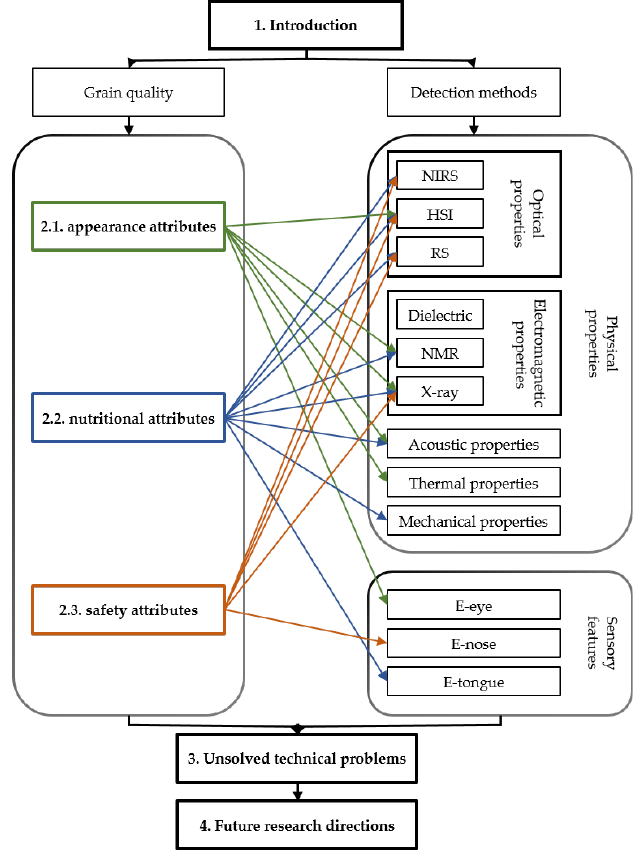
Figure 3. Block diagram of the article